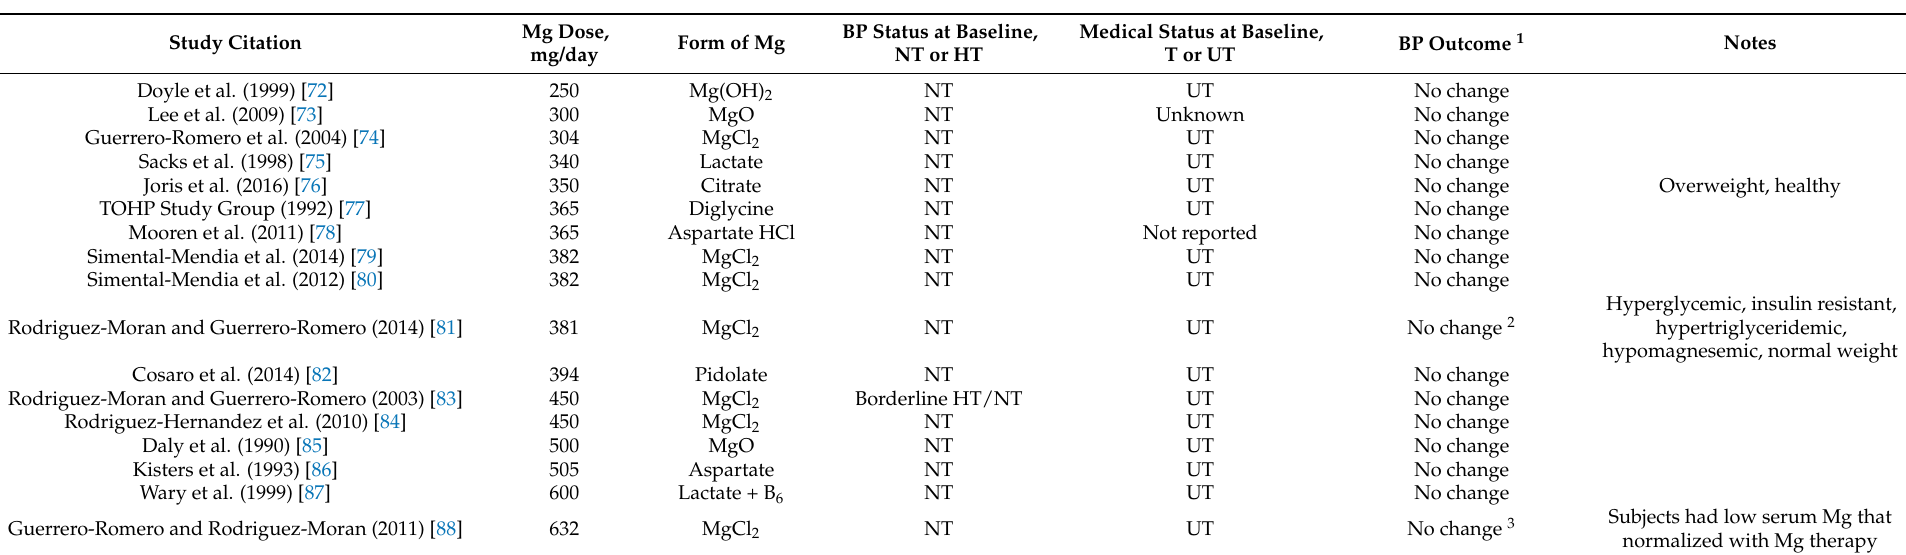
Table 4. Summary of magnesium supplementation studies for blood pressure in Normotensives (subjects untreated with antihypertensive medications, normotensive at